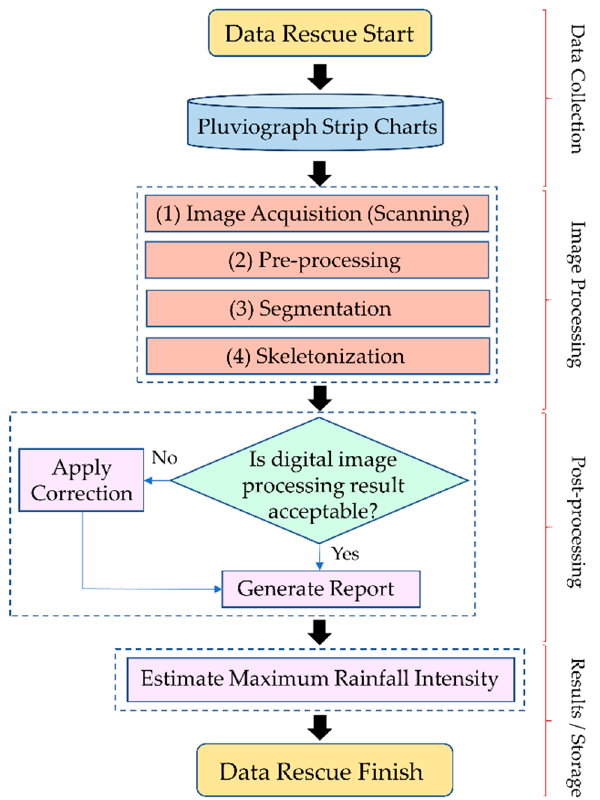
Figure 3. The flowchart for data rescue initiative (DRI) and the architecture for obtaining maximum rainfall intensities from digital image processing of PSCs.